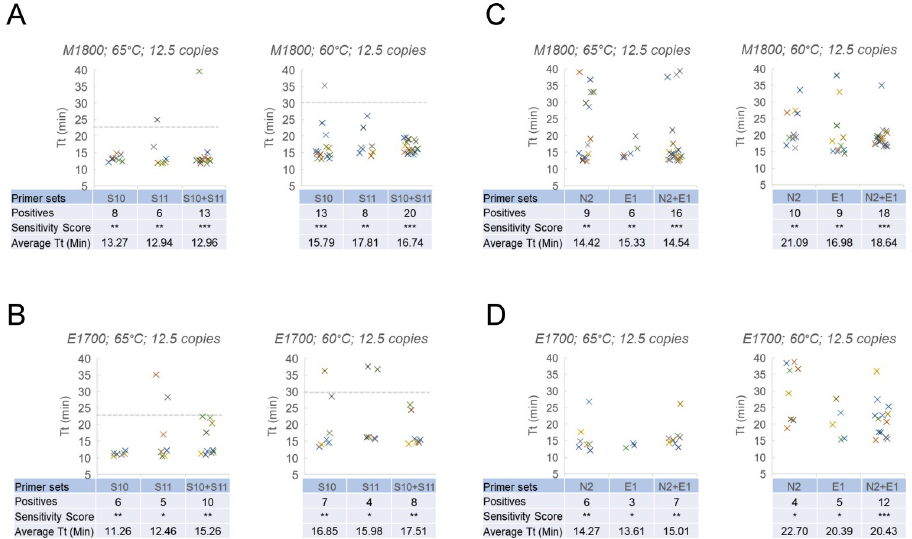
Fig 3. Effect of combining 2 primer sets in the presence of extremely low SARS-CoV-2 RNA template. A similar test was designed as Fig 2 but using only ~12.5 copies of SARS-CoV-2 RNA template per reaction. (A) Single primer set reactions for primers S10 and S11 versus a combination of them in M1800 at 65 and 60˚C. (B) In E1700 at 65 and 60˚C. (C) Single primer set reactions for primers N2 and E1 versus a combination of them in M1800 at 65 and 60˚C. (D) In E1700 at 65 and 60˚C. Sensitivity Score for 12.5 copies: ��� 12–24 positives; �� 6–11 positives; � 1–5 positives.